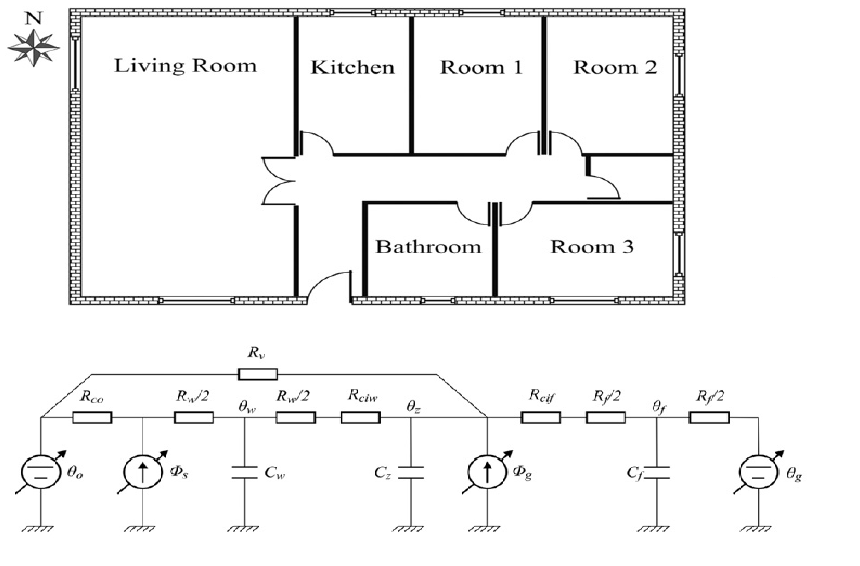
Figure 4. RC thermal network for single zone building [75].